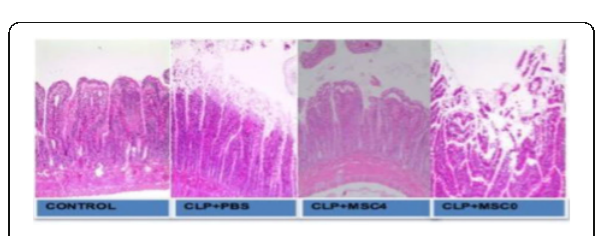
Fig. 59 (abstract A142). Histopathologi analysis of ilear